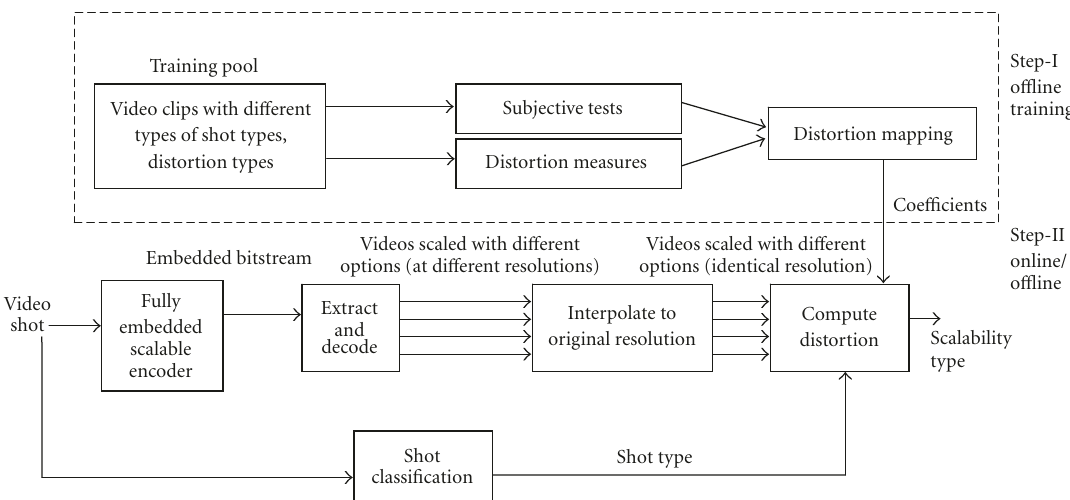
Figure 2: Although the SNR (a) scaled video is visually poorer, its PSNR is higher than the (b) spatially scaled (and interpolated to original size) video.